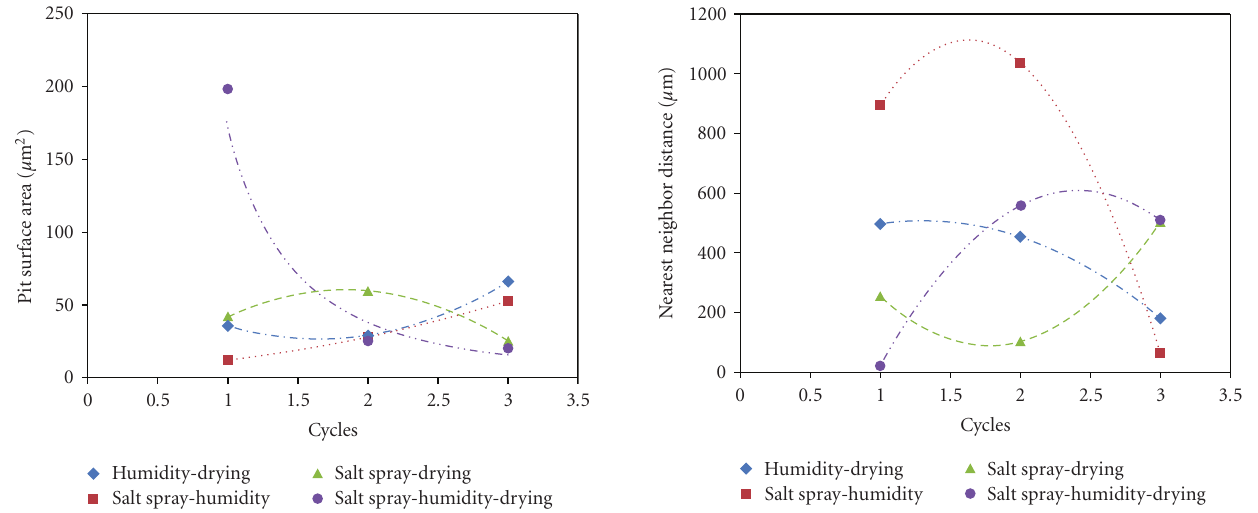
Figure 4: Average pit surface area of the AE44 coupons arranged by test condition based on cycle number.